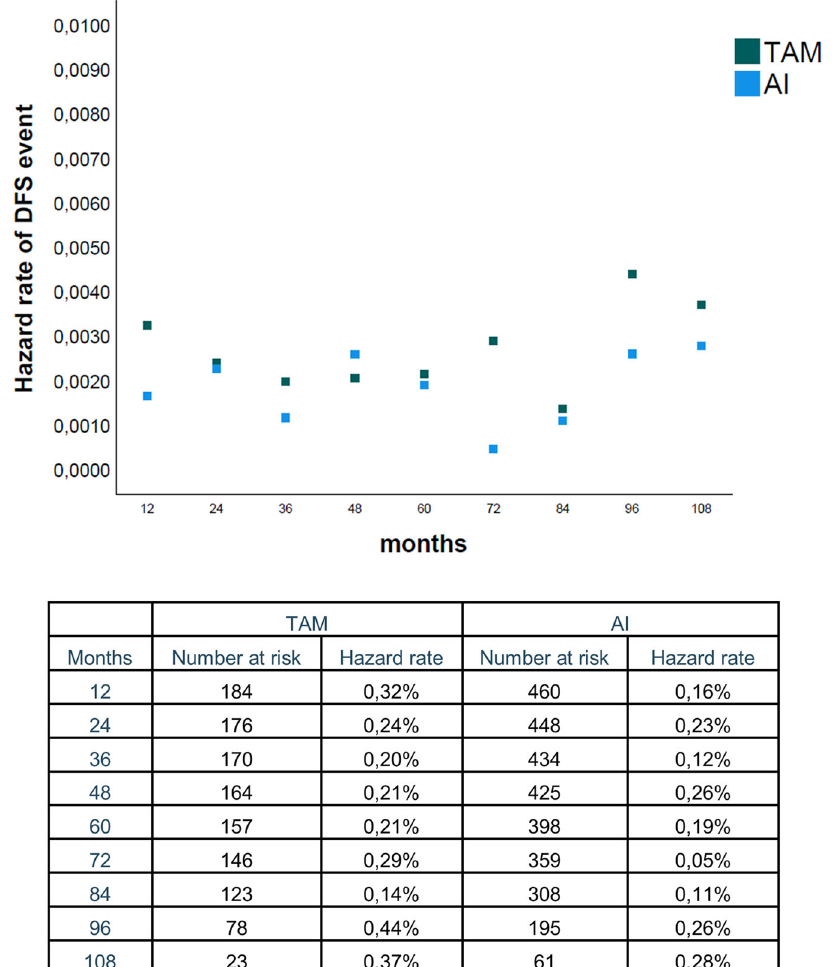
Fig. 2 Annual hazard rates of DFS events for patients treated with AI or TAM. The last timepoint considered is 108 months since the very low number of patients at risk in later